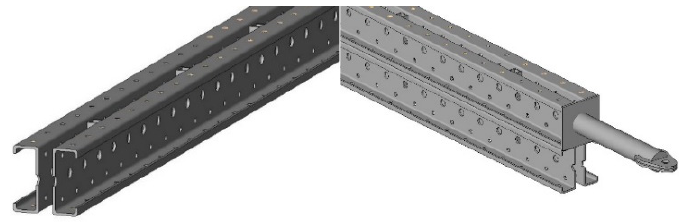
Figure 7. Complete architectural model and surrounding elements.